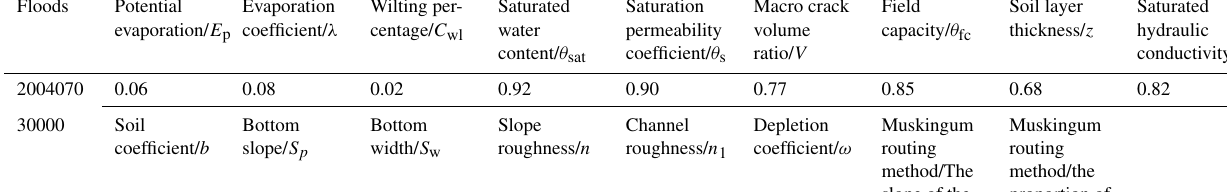
Table 4. The calculation results of the parameter sensitivity in the Liuxihe model.